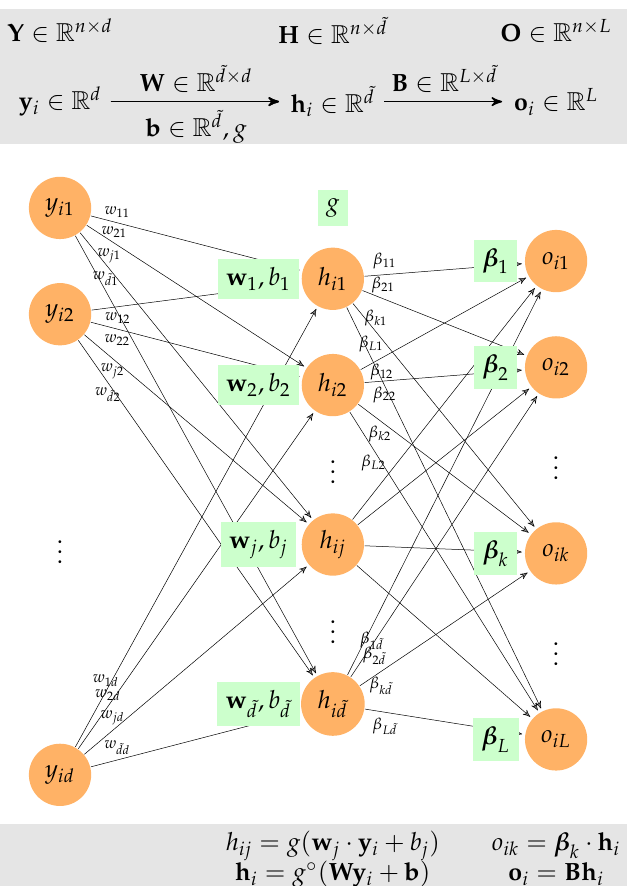
Figure A4. The ELM neural network consists of a hidden layer that converts the initial samples y i R d into the hidden feature vector h i ∈ ˜ d into the output vector o h i R ∈